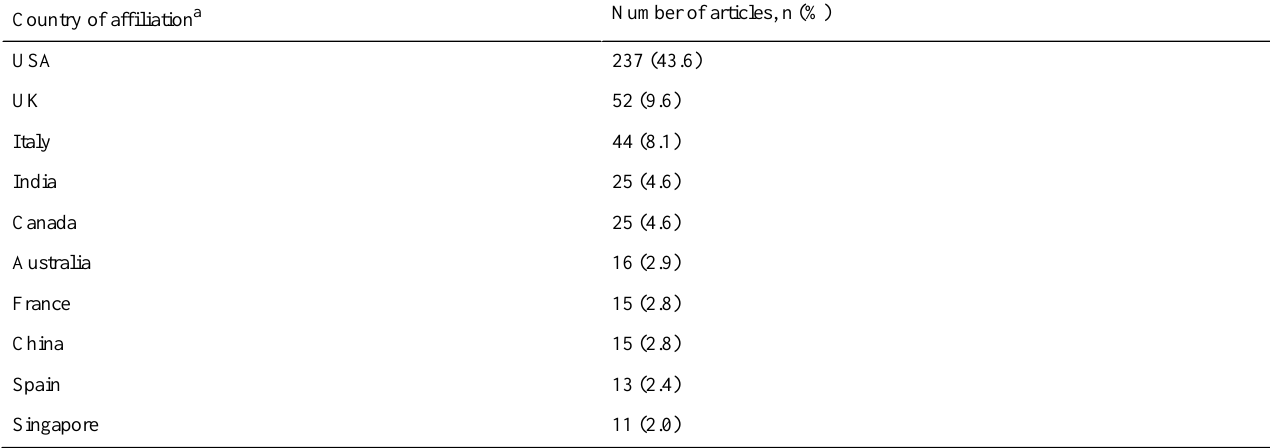
Table 1. Country of affiliation of the first authors (N=543).